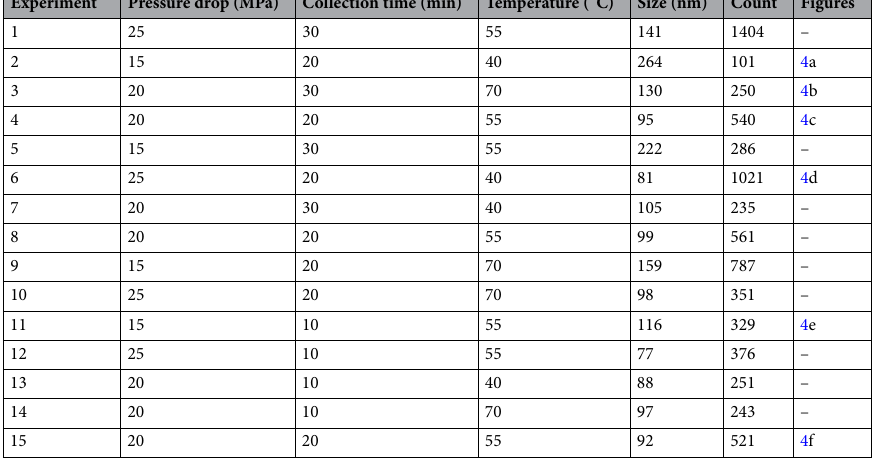
Table 2. Design matrix and the responses (BBD) for the production of